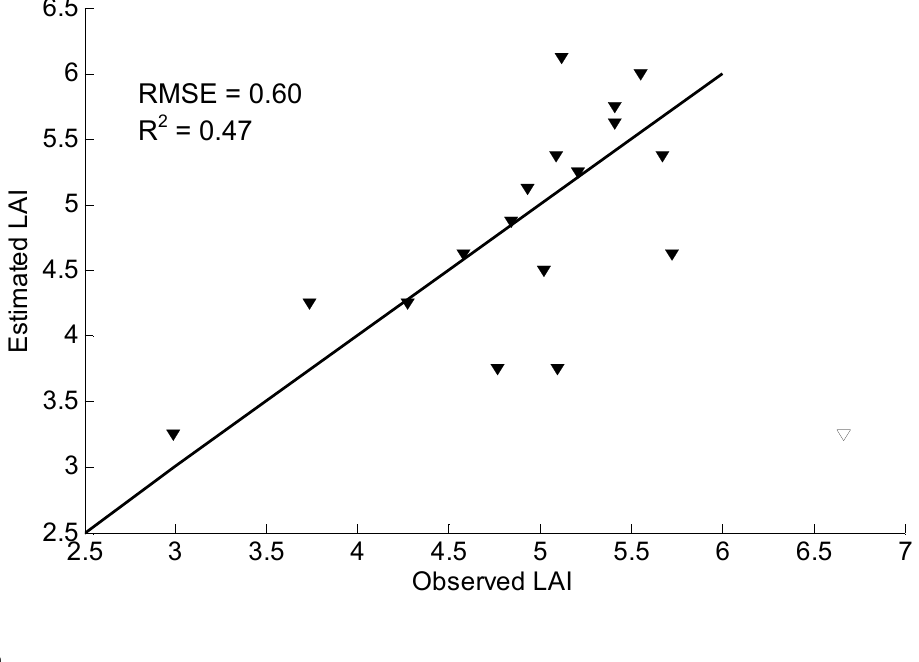
Figure 4. Observed versus best estimated LAI from untransformed AVIRIS reflectance (SPECTRAL BANDS). LAI was estimated as the median value of 30 solutions. The outlier that was not used for the calculation of 1:1 line and the inversion statistics is shown with a hollow diamond